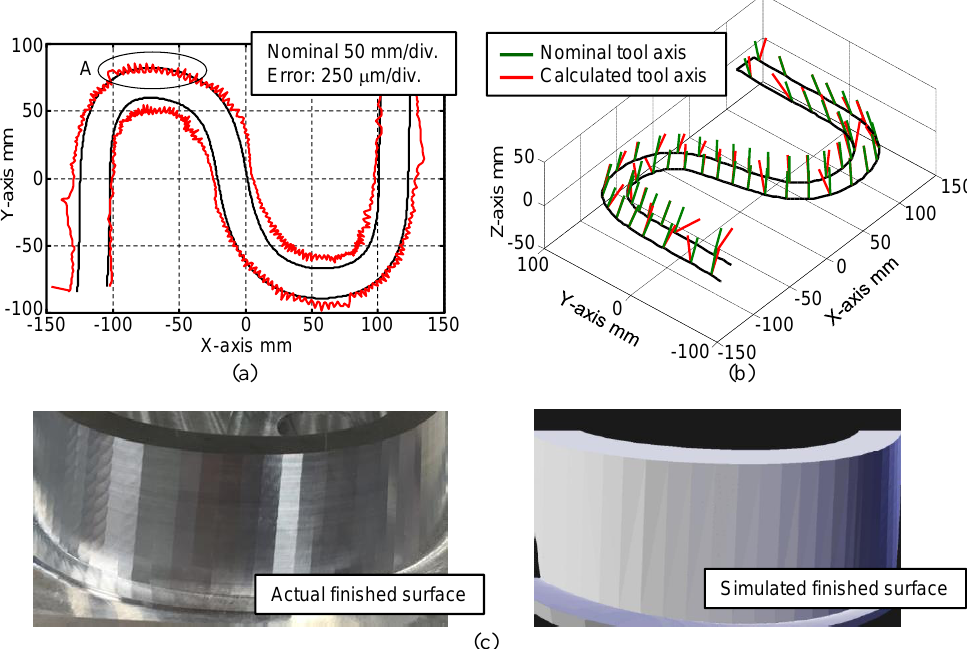
Figure 9. Tool-motion trajectory and finished surface corresponding to the 0.1-mm tolerance case: ( a ) Motion trajectory of tool center-point; ( b ) Tool orientation error; ( c ) Actual and simulated finished surfaces.